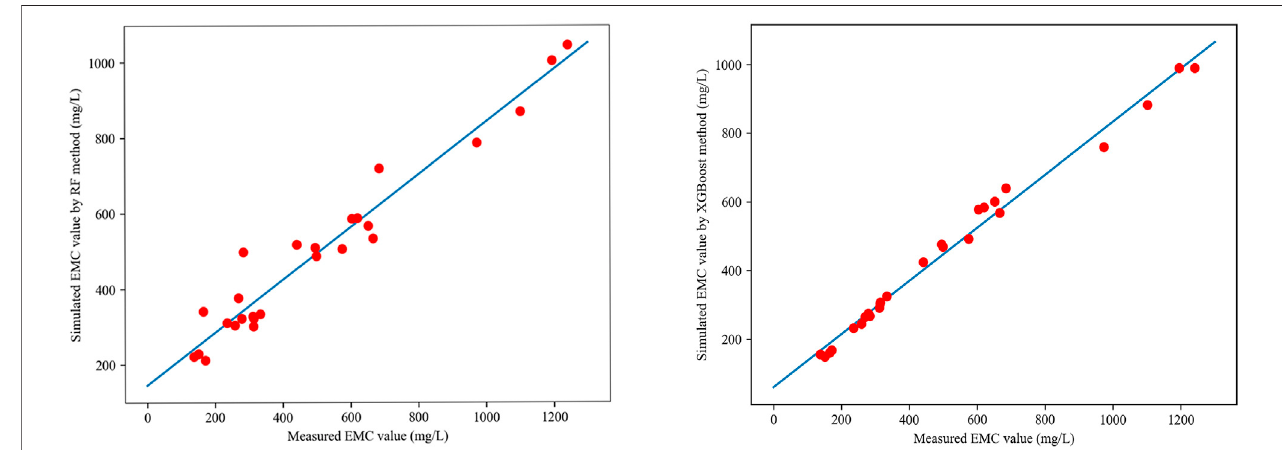
FIGURE 9 | Plot showing the training performance by RF and